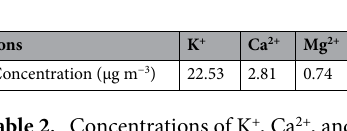
Table 2. Concentrations of K + , Ca 2+ , and Mg 2+